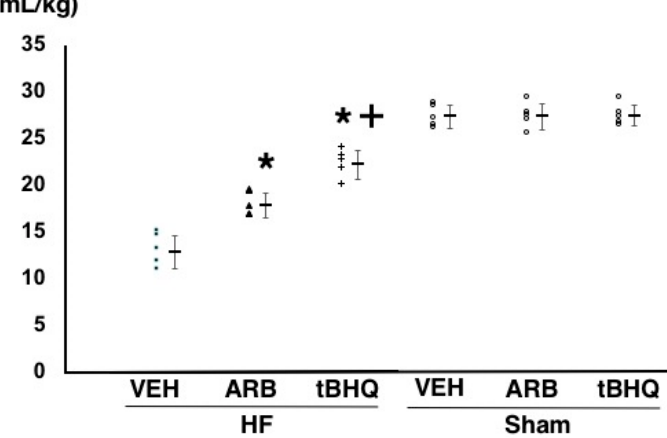
Figure 7. Infused volume at left atrial pressure to 14–16 mmHg of heart failure treated with intracerebroventricular (ICV) infusion of vehicle (HF-VEH), or with ICV infusion of angiotensin II type 1 receptor blocker (HF-ARB), or with ICV infusion of nuclear factor erythroid 2-related factor 2 activator, tert -butylhydroquinone (HF-tBHQ), or sham treated with ICV infusion of VEH, or with ICV infusion of ARB, or with ICV infusion of tBHQ. n = 5 for each group. All data are shown in dot plot and mean ± standard deviation. * p < 0.05 vs. HF-VEH in HF-ARB and HF-tBHQ. + p < 0.05 vs. HF-ARB in HF-tBHQ.